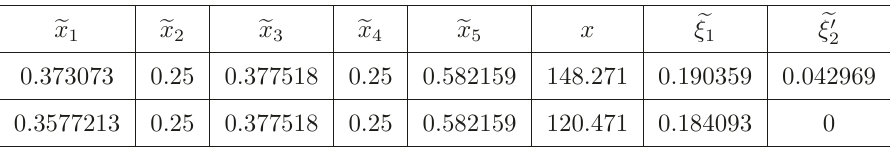
Table 5 . DT points in the UVFP catchment